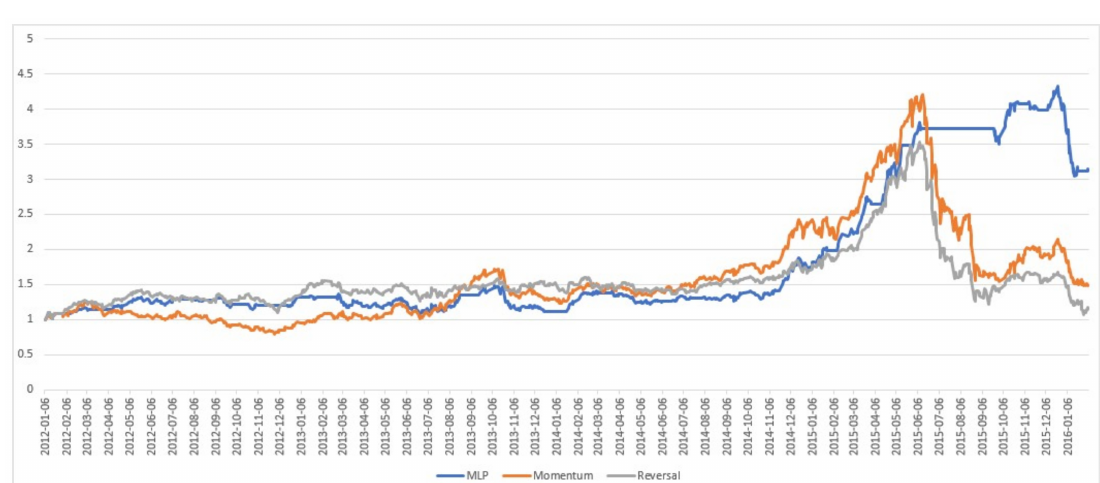
Figure 7. Portfolio performance comparison for the